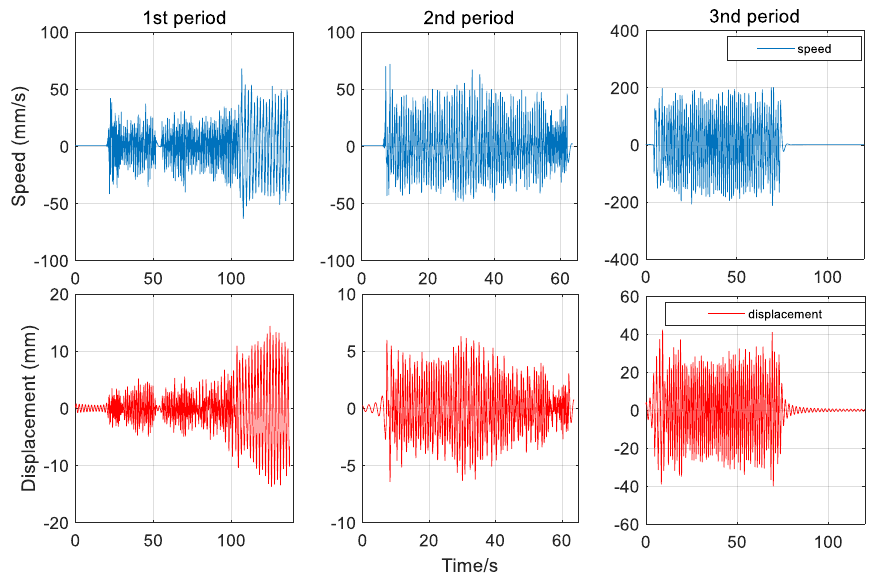
Figure 14. Integration results of the speedometer for three periods.